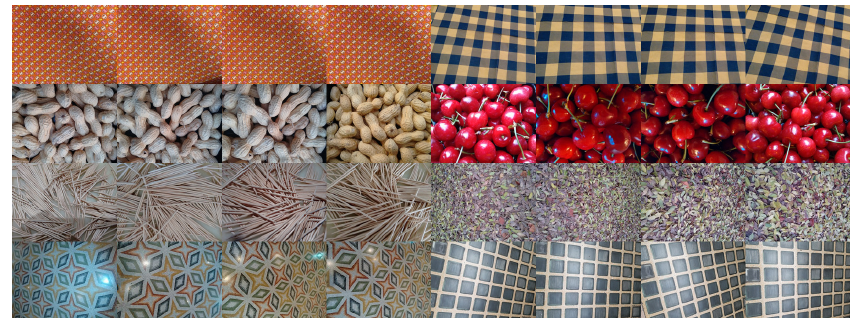
Figure 2. Samples of eight classes of textures in the T1K+ database.